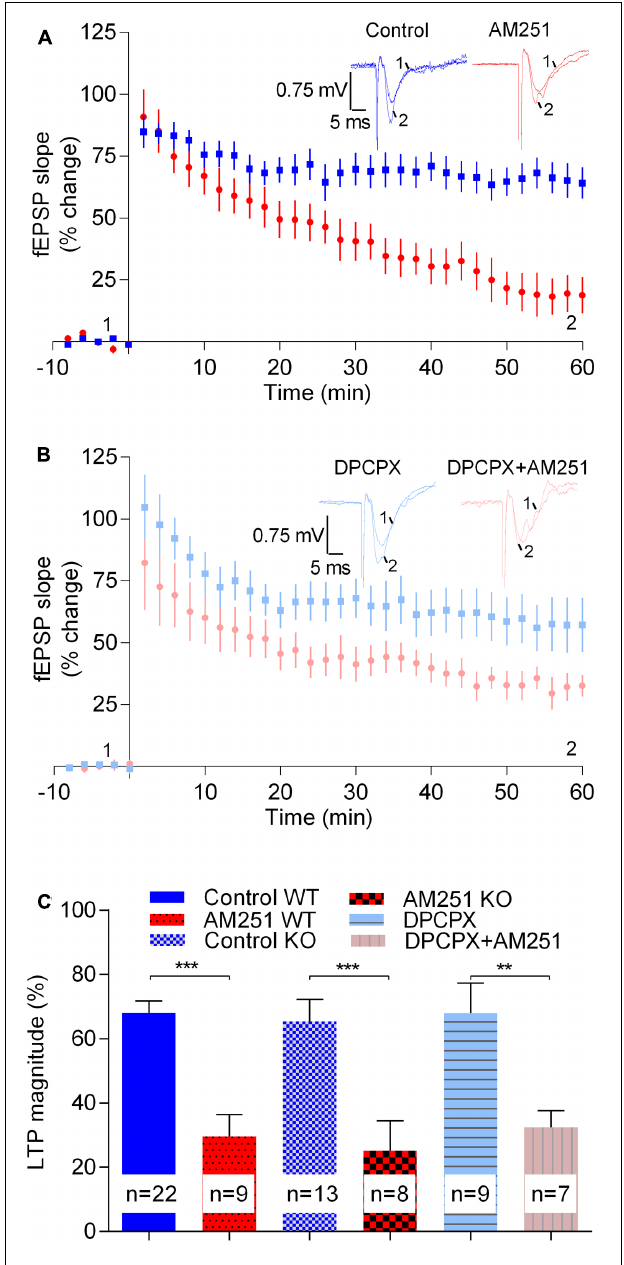
FIGURE 5 | The enhancement LTP caused by physiologically released eCBs does not result from enhanced adenosinergic tonus on A 1 R. (A) Data obtained in slices taken from A 1 R KO mice, LTP being induced by a strong- θ -burst in control conditions (no drugs, blue symbols and traces) or in the presence of 1 µ M of AM251 (red symbols and traces). (B) Data obtained in slices from wild-type mice in the presence of the A1R antagonist, DPCPX (50 nM) either in the absence (blue symbols and traces) or presence (pink symbols and traces) of AM251 (1 µ M). (C) Quantification of LTP magnitude under the indicated conditions. In all cases LTP was induced by a strong- θ -burst. Data from WT mice in the absence of DPCPX (control WT, AM251 WT, panel C ) are the same as that shown in Figure 2B , but is represented in this figure to allow comparisons with data from A 1 R KO mice and with data from WT slices in the presence of DPCPX. ∗∗ p < 0.01; ∗∗∗ p < 0.001 ( F ( 5 , 62 ) = 10.0, one-way ANOVA with Sidak’s correction). For further details see legend to Figure 1